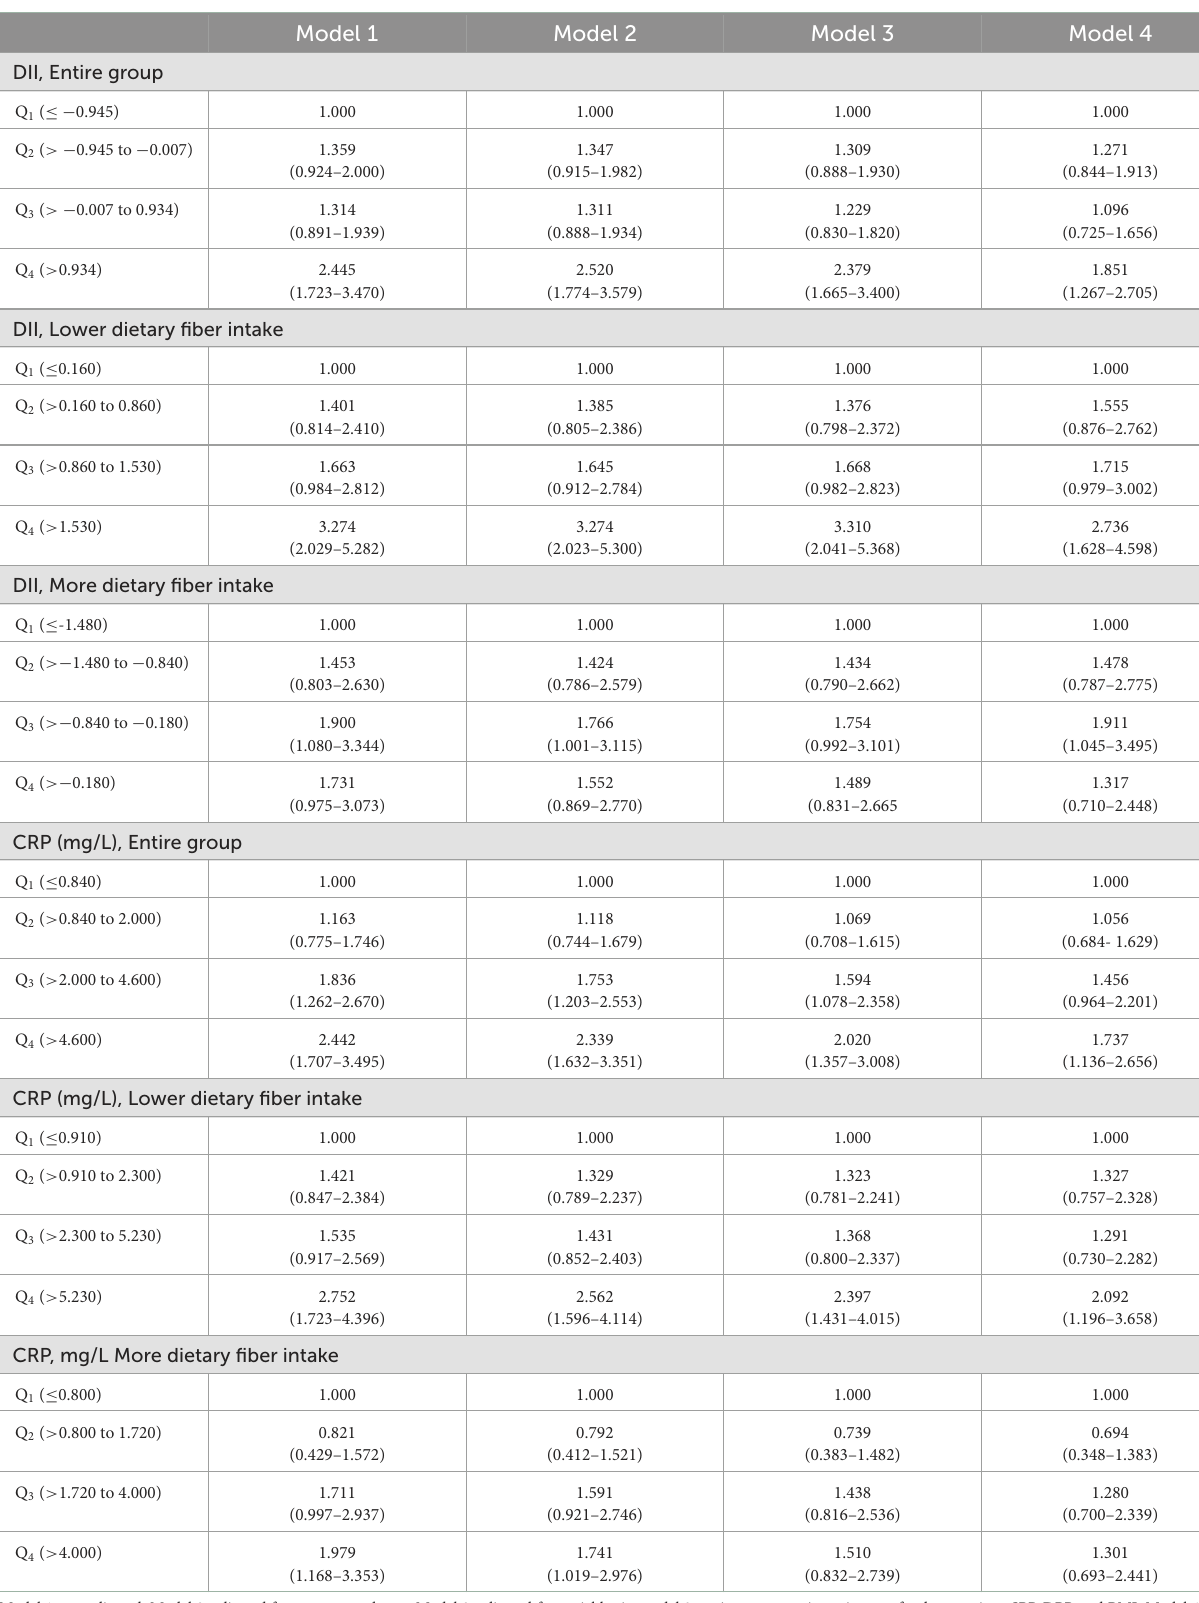
TABLE 5 OR and 95% CI for depressive symptoms (moderately severe and severe depressive symptoms) according to DII scores and CRP in the entire group and different dietary fiber intake groups. Model